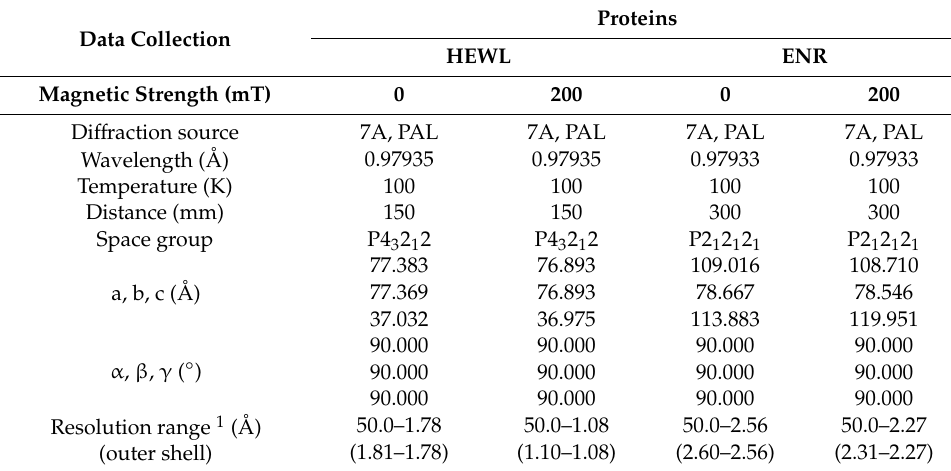
Table 1. Summary of the X-ray di ff raction data of the HEWL and ENR crystals grown with and without a magnetic field (values in parentheses represent the highest resolution